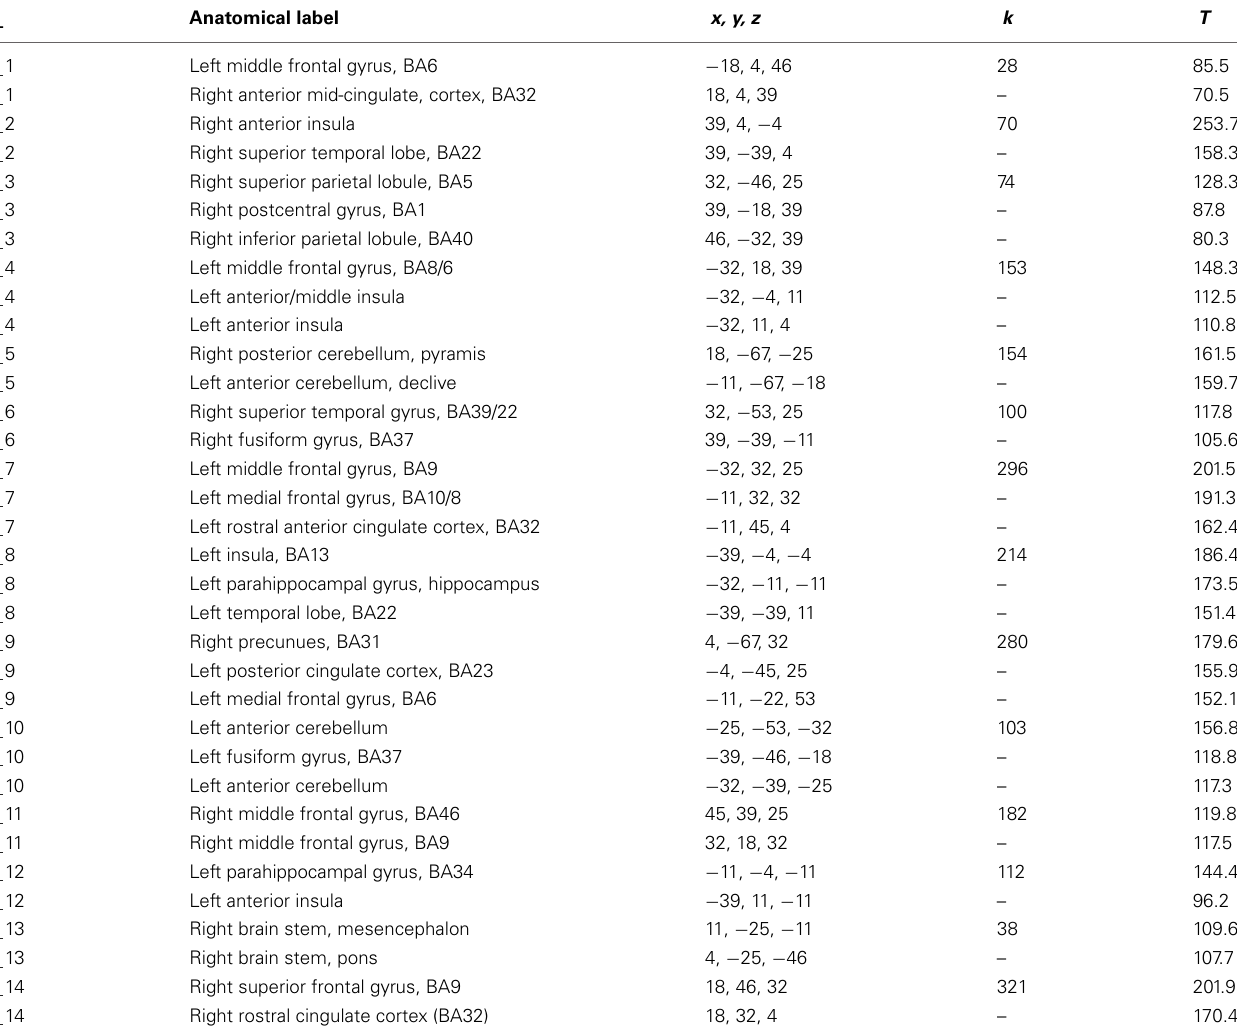
Table 2A | Anatomical labels, Talairach coordinates, cluster sizes, and T -values of independent components clusters seen during LEP period (IC L